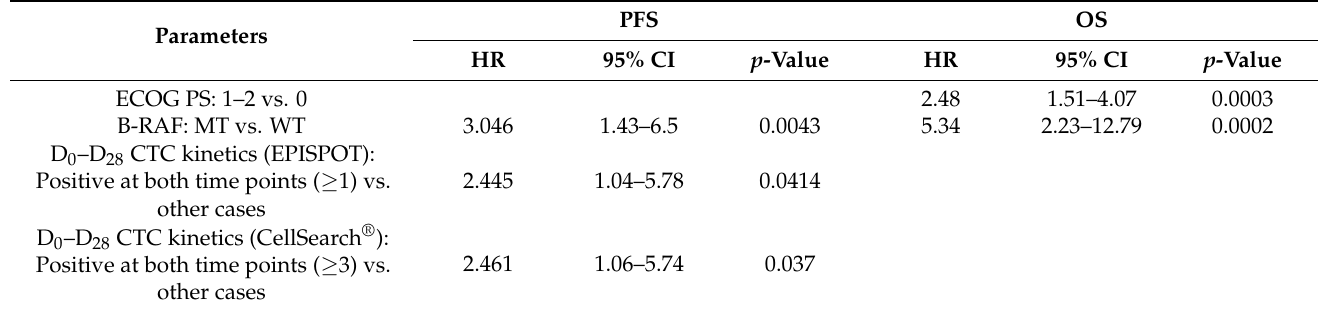
Table 3. Multivariate Cox regression analysis for PFS and OS